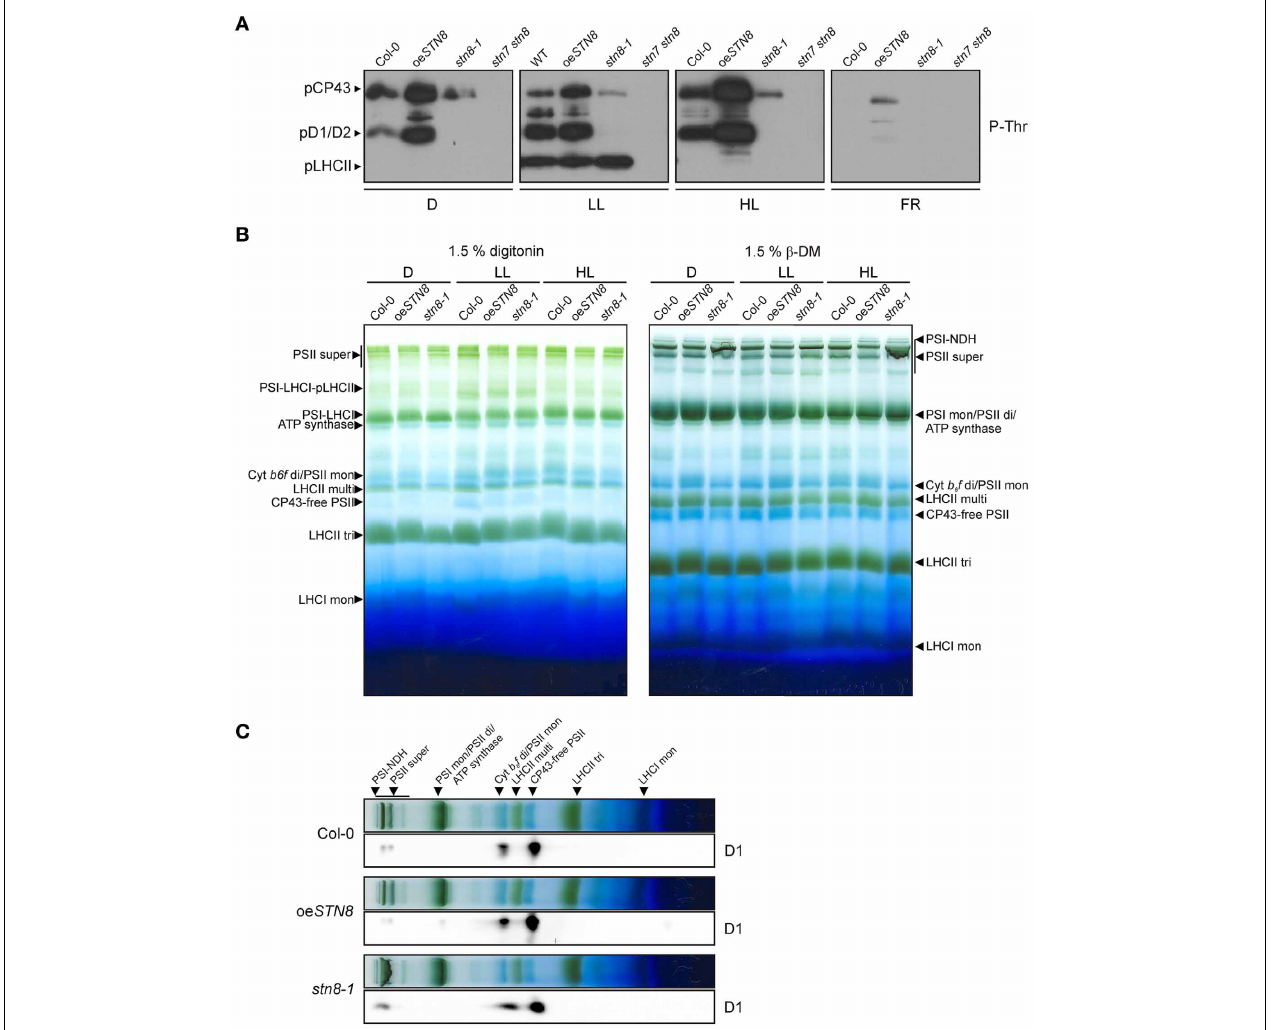
were solubilized with 1.5% digitonin (left panel) or 1.5% β -DM (right panel) and separated by BN-PAGE. Protein-Chl complexes are indicated by black arrowheads. The bands detected were identified as specific protein complexes in accordance with previously published profiles (Armbruster et al., 2013): PSI-LHCI-pLHCII supercomplex (PSI-LHCI-pLHCII), PSI-LHCI supercomplex (PSI-LHCI), PSI-NDH supercomplex (PSI-NDH), PSII supercomplexes (PSII super), PSI monomers and PSII dimers (PSI mon and PSII di), PSII monomers and dimeric Cyt b 6 f (PSII mon and Cyt b 6 f di), PSII monomers w/o CP43 (CP43-free PSII), multimeric (LHCII multi), trimeric (LHCII tri) and monomeric (LHCII mon) LHCII. (C) BN-PAGE lanes bearing HL-treated samples corresponding to those shown in the right panel of (B) were subjected to SDS-PAGE in the second dimension and probed with D1-specific